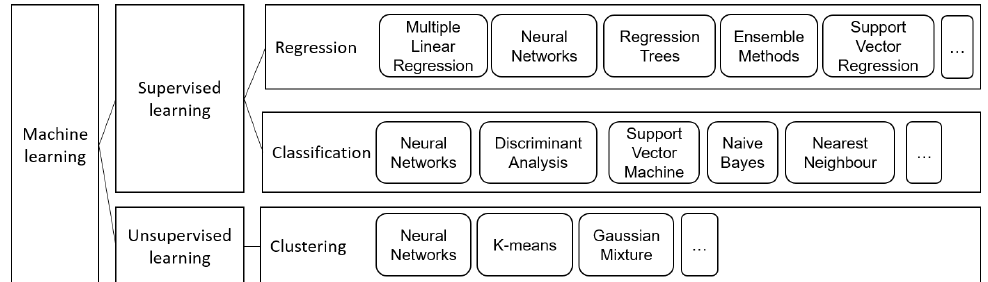
Figure 2. Main machine learning techniques used in dam safety assessment